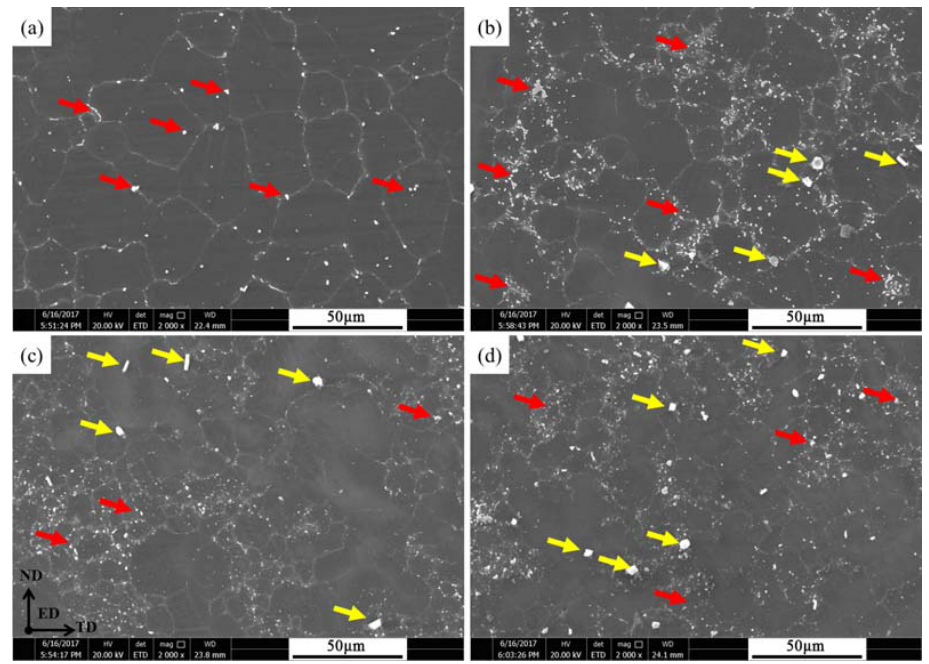
Figure 3. SEM images of the as ‐ extruded alloys: ( a ) AZ80; ( b ) AZ80M1; ( c ) AZ80M2; and ( d ) AZ80M3. ( β‐ Mg 17 Al 12 phase marked with the red arrow; Al 2 Y phase marked with the yellow arrow).